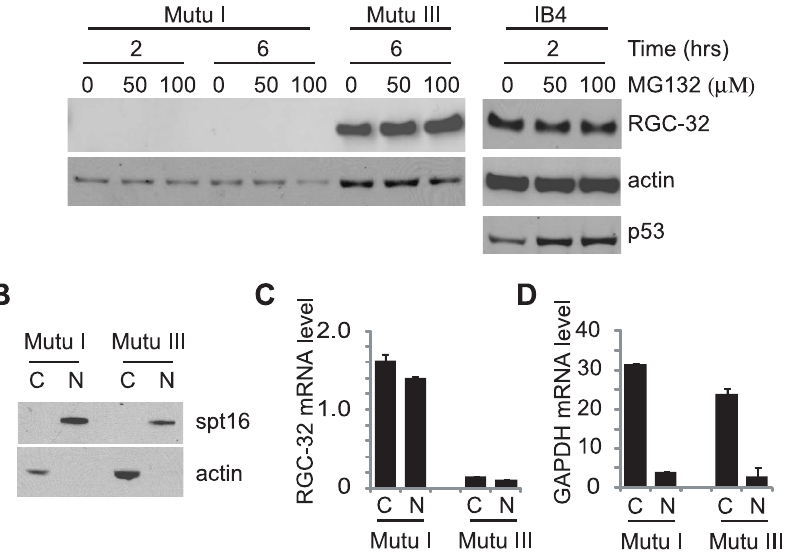
Figure 5. Proteasomal degradation or blocked mRNA export doesn’t prevent RGC-32 protein expression in latency I cells. (A) Mutu I, Mutu III and IB4 cells were treated in parallel with 50 or 100 m M MG132 and harvested after 2 or 6 hrs for Western blot analysis. Blots were probed in sections for RGC-32 and actin. IB4 blots were also probed for p53 as a control for MG132-mediated protein stabilization through proteasomal inhibition. (B) Mutu I and III cells were fractionated into cytoplasmic (C) and nuclear (N) protein extracts and analysed by Western blotting for nuclear (Spt16) and cytoplasmic (actin) marker proteins to confirm purity of the fractions. RGC-32 (C) and GAPDH (D) transcript levels were quantified by Q- PCR in cytoplasmic (C) and nuclear (N) RNA extracts prepared in parallel to protein extracts.